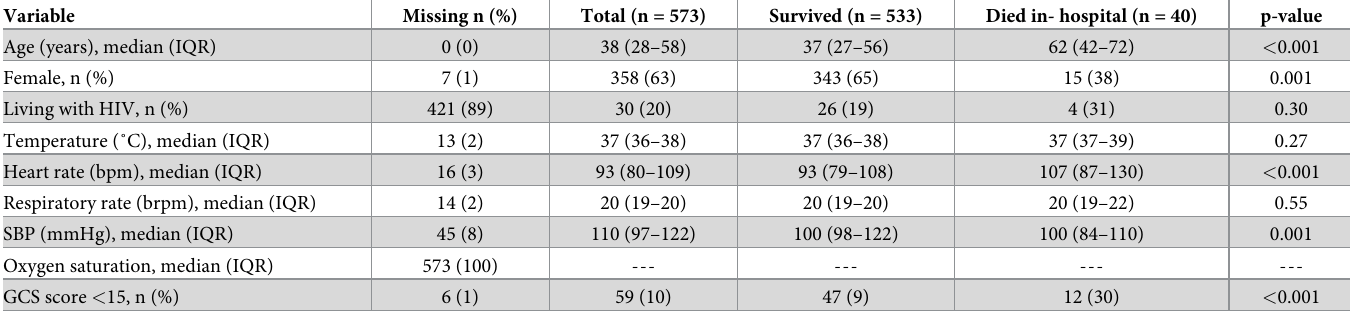
Table 2. Population characteristics of adult patients admitted to hospital with acute infection in Gitwe, Rwanda including a comparison between those who sur- vived hospitalization and those who died